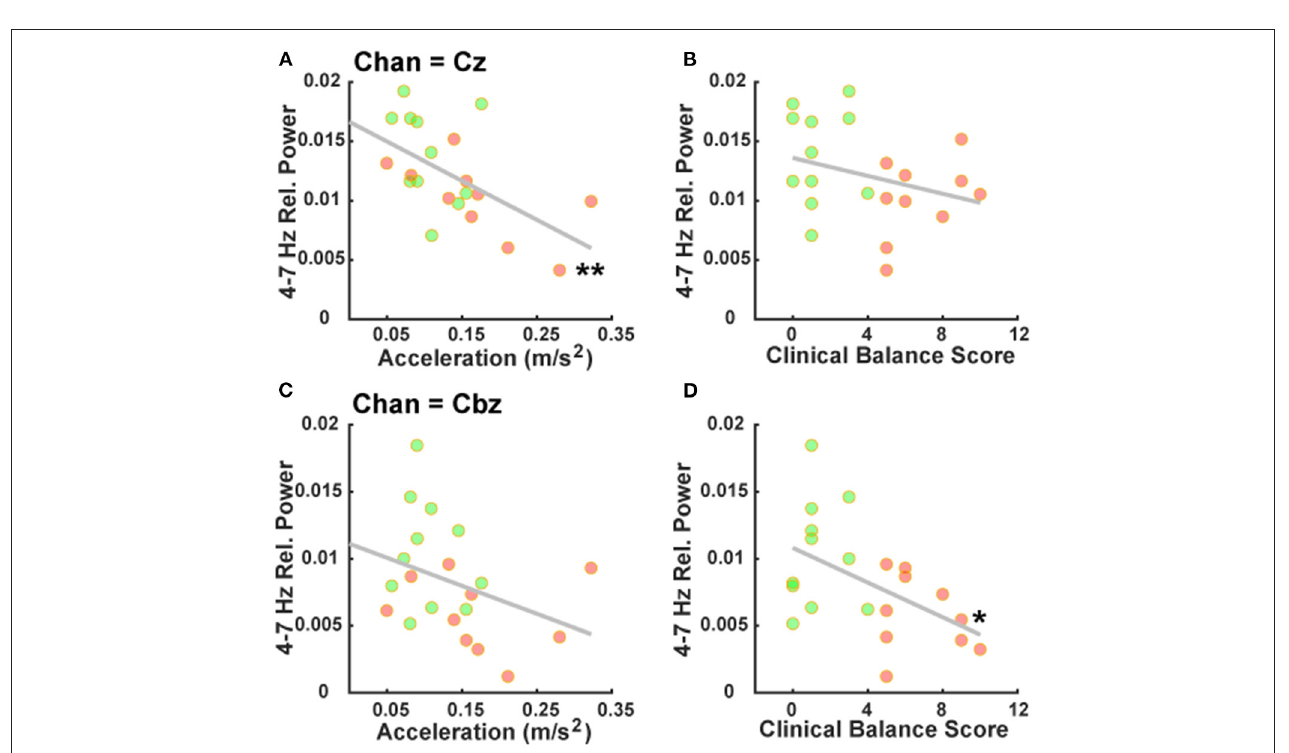
FIGURE 3 | Mid-frontal and mid-cerebellar theta-band power values are associated with distinct measures of postural instability. (A) Decreased mid-frontal theta-band (4–7Hz) power is significantly associated with higher mean acceleration during a postural control task. (B) Mid-frontal theta-band power is not significantly associated with clinical balance scores. (C) Mid-cerebellar theta-band power is not significantly associated with mean acceleration during a postural control task. (D) Decreased mid-cerebellar theta-band power is significantly associated with higher (worse) clinical balance scores. * p < 0.05, ** p < 0.01. Green and red markers represent PDPI– and PDPI + subjects,